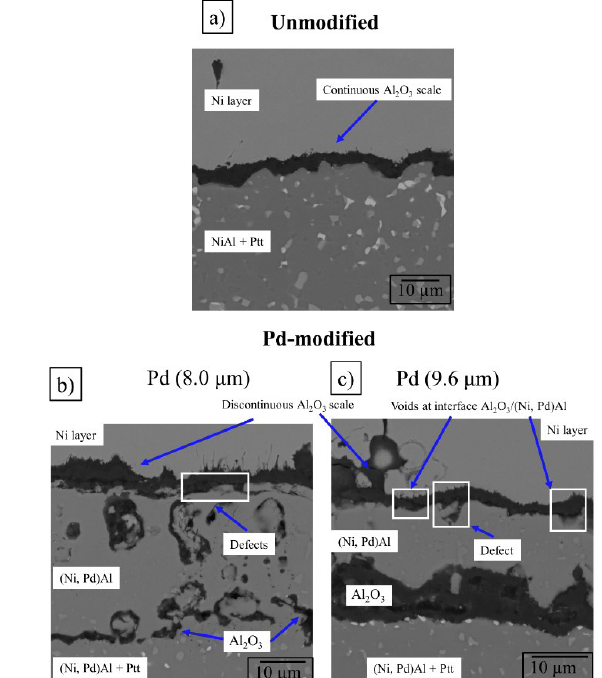
O and β-(Ni,Pd)Al /Al O interfaces in aluminized coatings after isothermal oxidation at 1000 °C for 200 h: a) 2 3 2 3